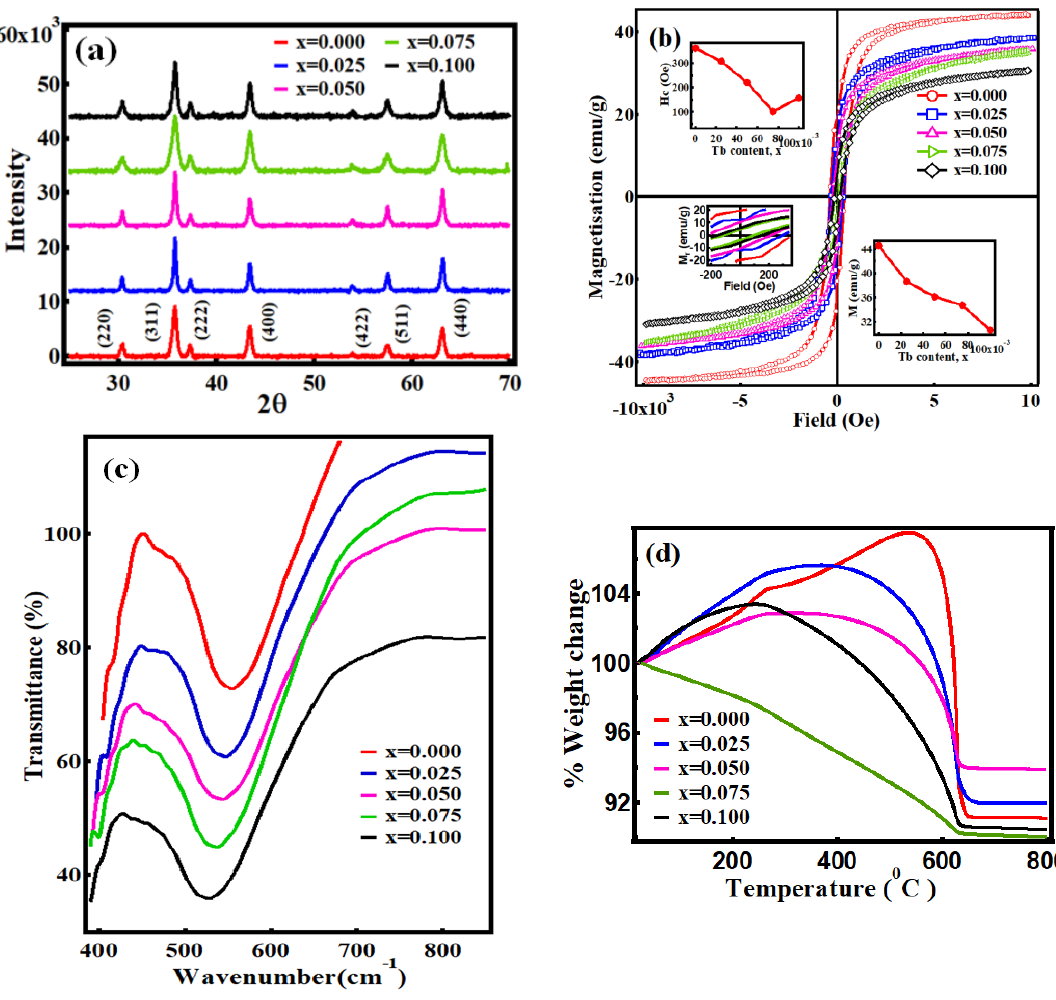
Figure 1. ( a ) X-ray diffraction (XRD) patterns of the NiTb x Fe 2−x O 4 (0.0 ≤ x ≤ 0.1) nanoparticles. ( b ) Hysteresis loops at room temperature, M vs. H of NiTb x Fe 2−x O 4 . ( c ) Fourier transform infrared spectra of NiTb x Fe 2−x O 4 . ( d ) Thermogravimetric Analysis (TGA) curves of NiTb x Fe 2−x O 4 . TGA measurement was done in the presence of the magnetic field, thus the %Wt. change refers to the change in magnetic force. Table 1. Values from the magnetic isotherms and Curie temperature, Tc , of NiTb x Fe 2 − x O 4 .